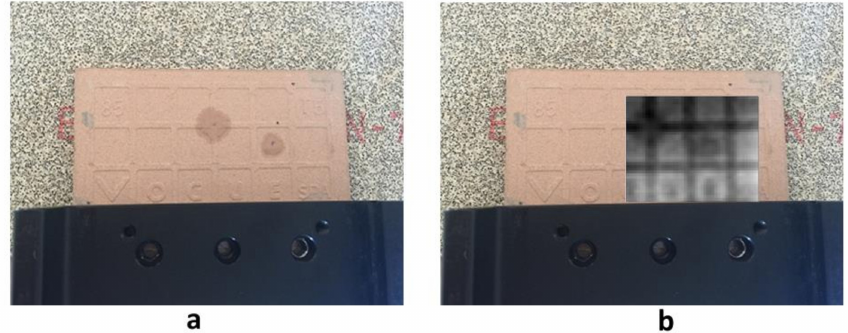
Figure 19. Reverse side of a ceramic tile moistened with two droplets of water ( a ) visible image of the ceramic reverse side; ( b ) visible image of the ceramic reverse side with THz image (taken from the other side) superimposed. Size of the THz images: 50 × 50 mm 2 .